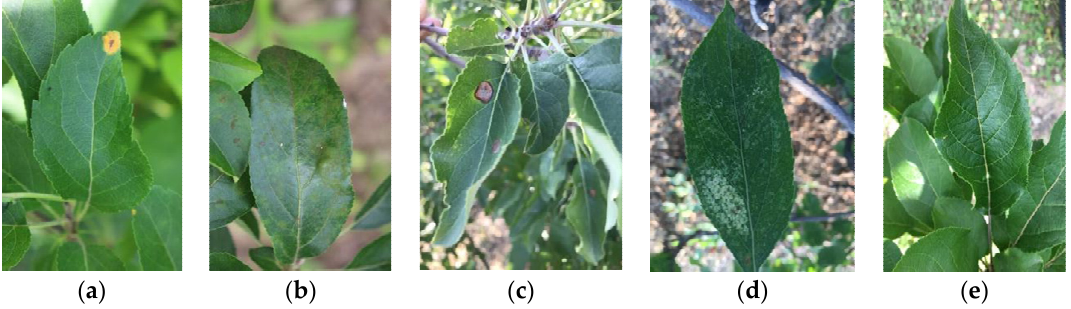
Figure 1. Example of apple leaf images: ( a ) rust; ( b ) scab; ( c ) ring rot; ( d ) Panonychus ulmi; ( e ) healthy.